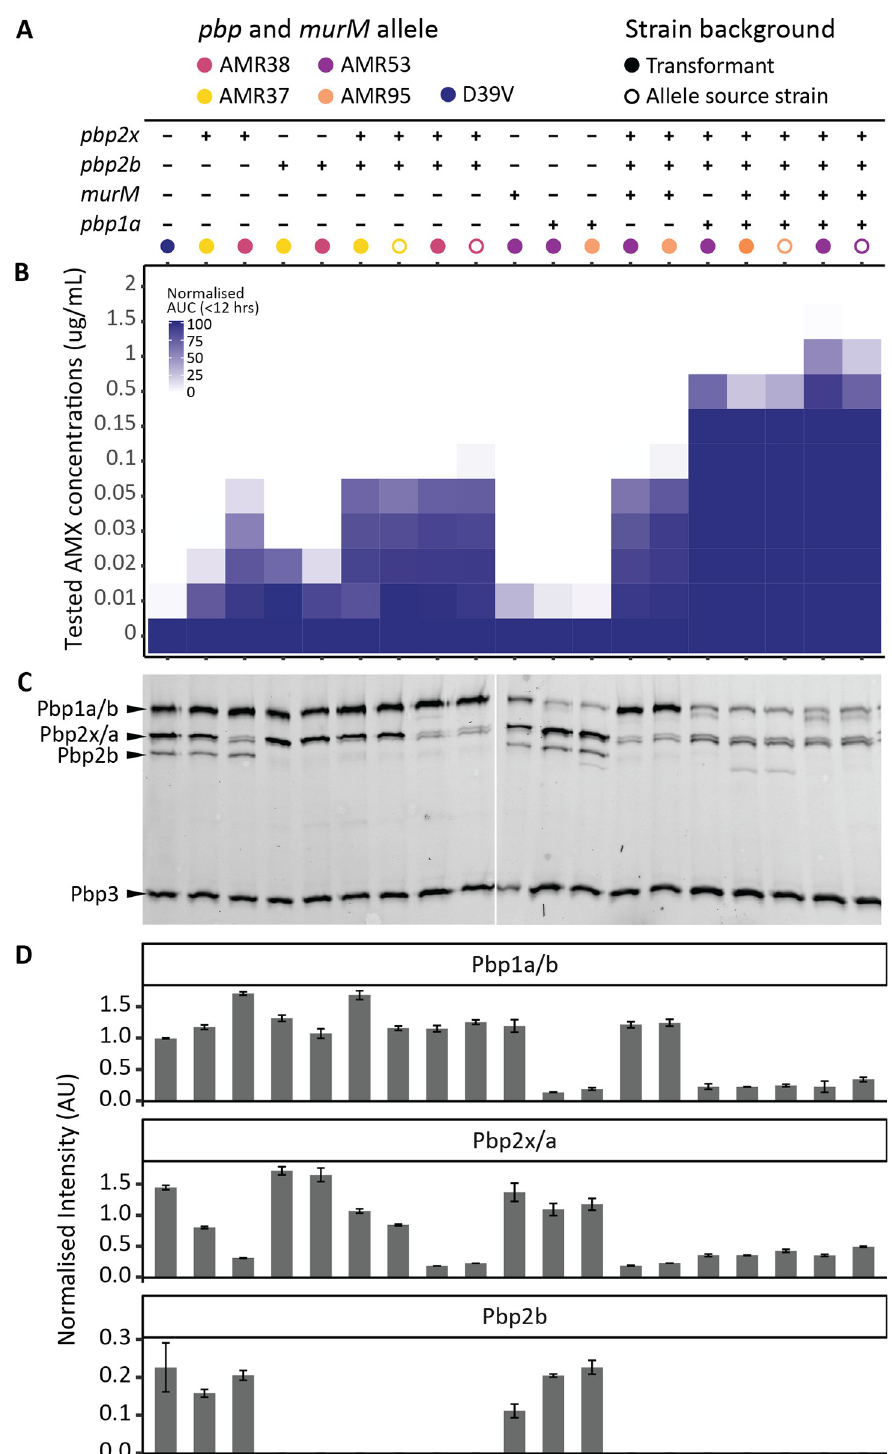
Fig 8. Recombinant PBP proteins visualized by PBP-bocillin binding affinities. Transformed AMX resistant strains produce mosaic PBPs with reduced affinity for Bocillin-FL. Each column shows the phenotypic characterization of one pbp and murM allele swap strain. (A) Table showing the presence (+) and absence (-) of alleles from different source strains (colour). Allele source strains are also included and are indicated by the unfilled circles. (B) Survival in different AMX concentrations quantified by determining the area under the growth curve (AUC) after 12 hours growth in